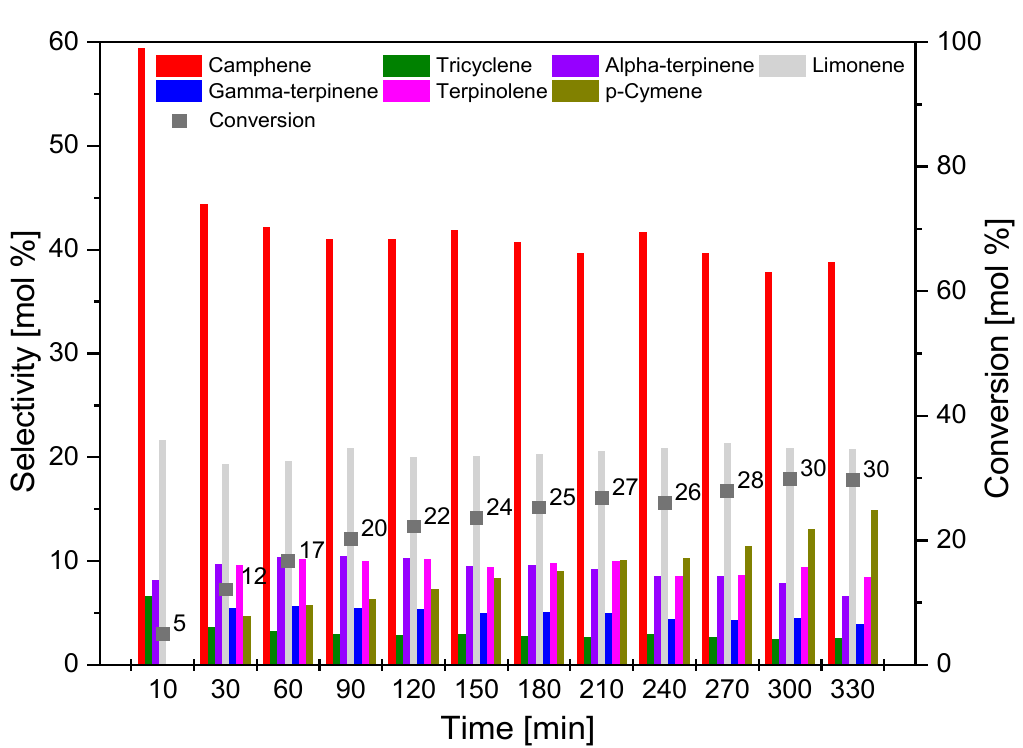
Figure 15. Influence of time on the selectivity of the main products and the conversion of organic raw material (alpha-pinene) for S_AC sample.